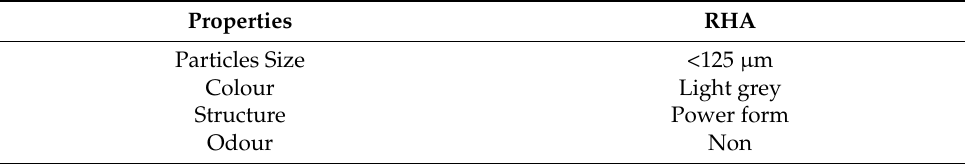
Table 4. Physical properties of RHA after